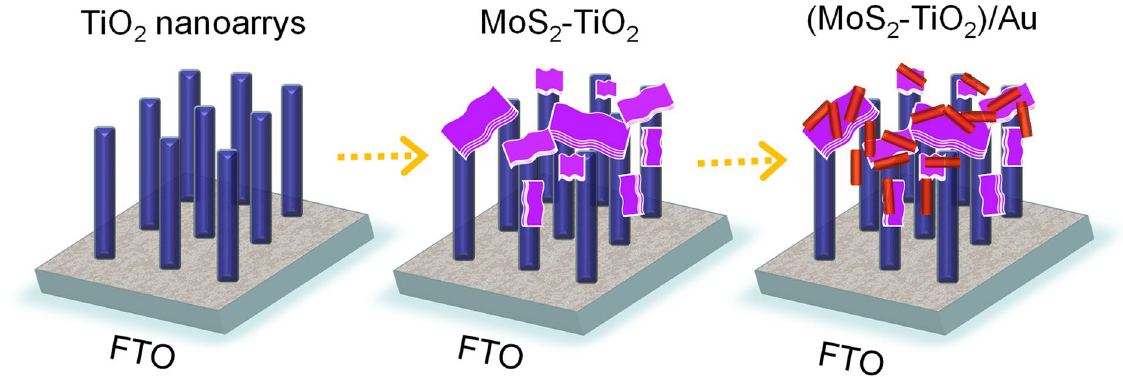
Figure 1. Schematic illustration of preparing (MoS 2 -TiO 2 )/Au nanocomposites.